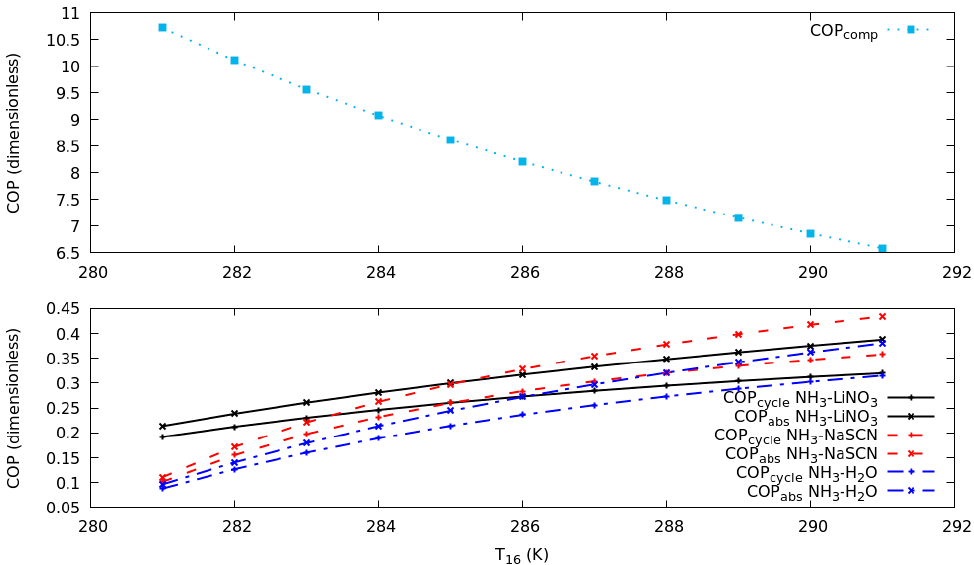
Figure4. Coe ffi cientofperformanceinthecompressionandabsorptioncyclesagainstT 16 incompression Figure 4. Coefficient of performance in the compression and absorption cycles against T 16 in cycle for T 19 of 263 compression cycle for T 19 of 263 K.